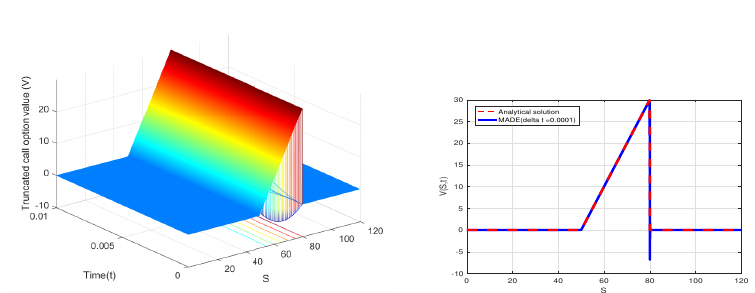
Figure 7. Spurious oscillations in the solution provided by the MADE scheme with ∆ S = 0.01, ∆ t = 10 − 4 . Parameter values: r = 0.07, σ = 0.001, T = 0.01, U = 80, K = 50, L = 20, S